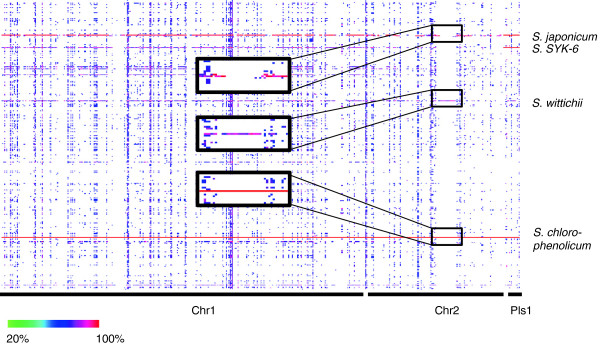
Use of CodaChrome to investigate the evolutionary history of an indel. A CodaChrome heat map is shown in which the proteome of Sphingobium chlorophenolicum was loaded as the seed sequence and the rows were not sorted. The boxed regions show a section of the proteome of S. chlorophenolicum that lacks orthologs in the closely related S. japonicum but has orthologs in the more distantly related S. wittichii.